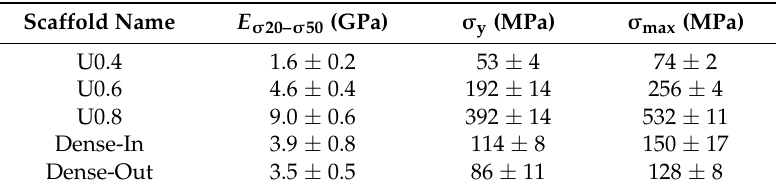
Table 2. The summary of the mechanical properties of uniform and gradient BCC structures measured by compression tests. (Mean ± SD).